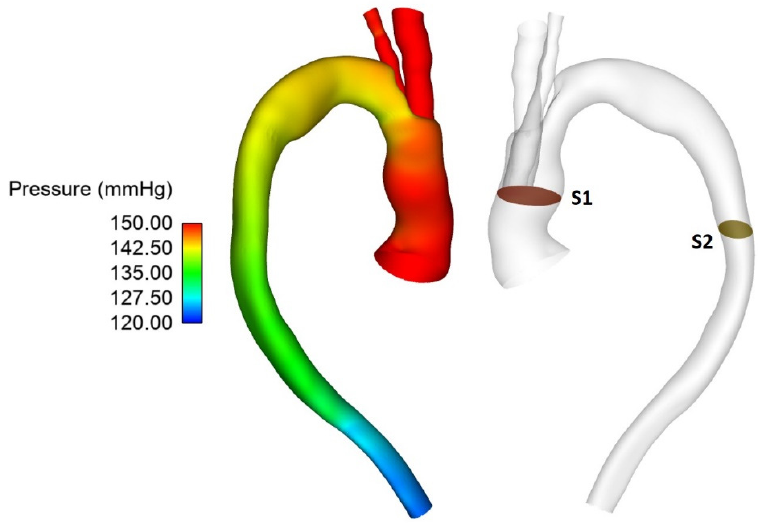
Figure 6. Pressure distribution throughout the vessel at peak systole for Patient 1 (left) with the pressure difference measured between planes S1 and S2 (right). Table 1. Pressure drop across the endograft for different tunnel branch diameters.